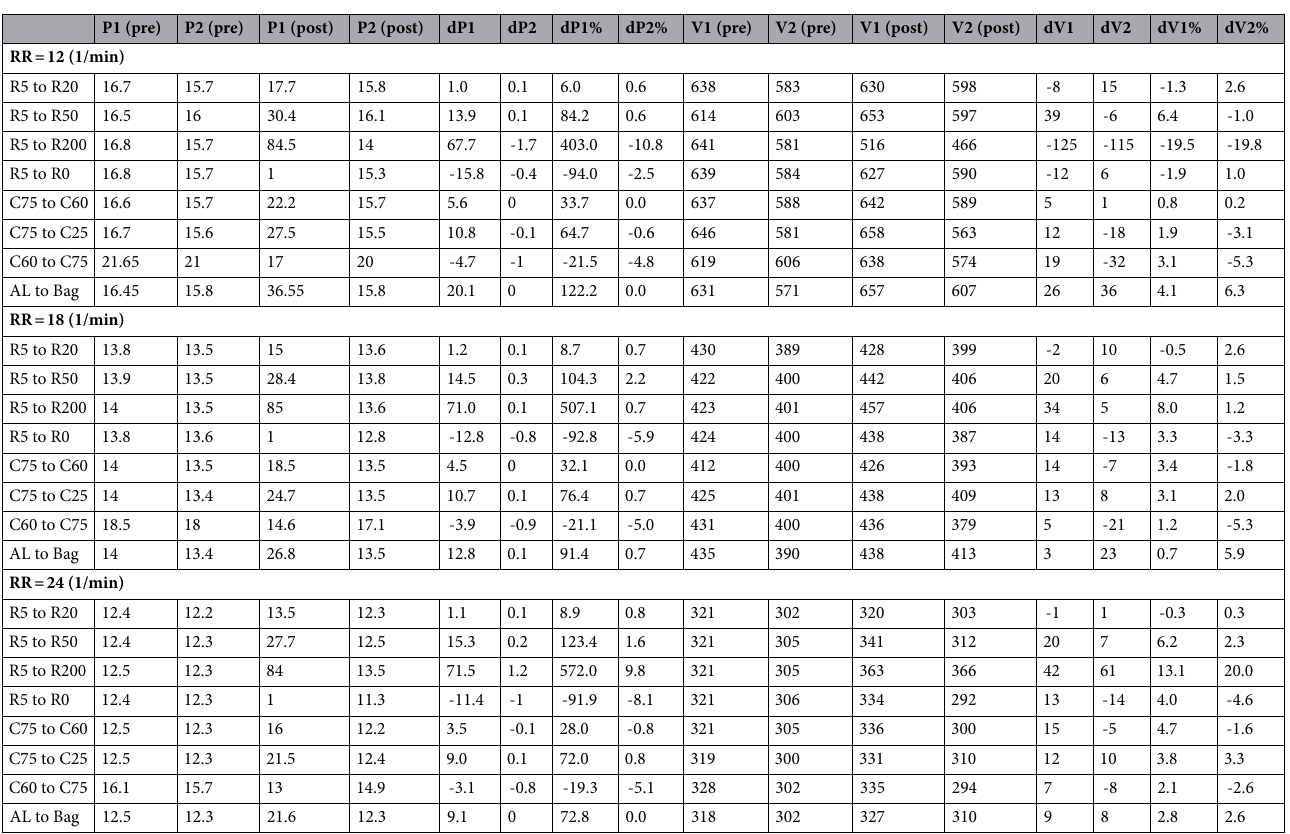
Table 4. Step changes (events) of the resistance ( R ) and compliance ( C ) in object #1 (left artificial lung). All pressures refer to the respiratory peak pressure, expressed in cmH 2 O. All volumes refer to the respiratory tidal volume, expressed in ml. pre, Index referring to the variable before the event; post, Index referring to the variable after the event; P1 , P2 , Pressures for object #1, #2, respectively; V1 , V2 , Volumes for objects #1, #2, respectively; dP1 = P1 (post)– P1 (pre); dP2 = P2 (post)– P1 (pre); dP1 %, Relative percentage error for dP1 ; dP2 %, Relative percentage error for dP2 ; dV1 = V1 (post)– V1 (pre); dV2 = V2 (post)– V2 (pre); dV1 %,